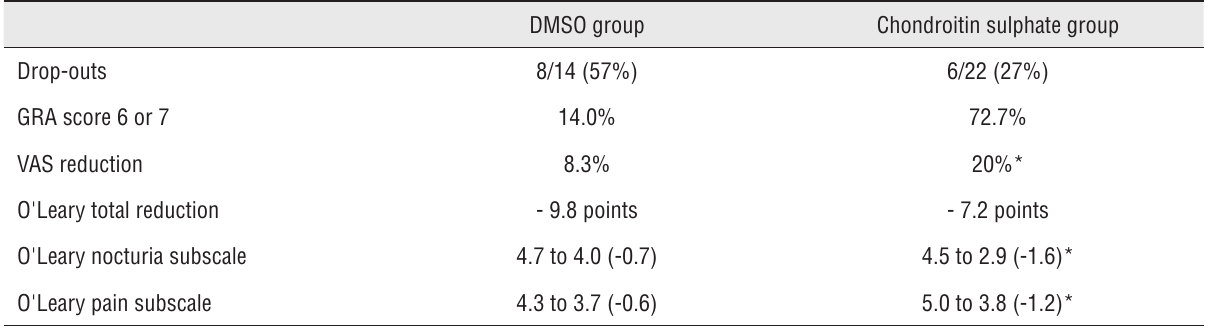
Table 3 - Drop-outs, Global Response Assessment, parameter changes vs.